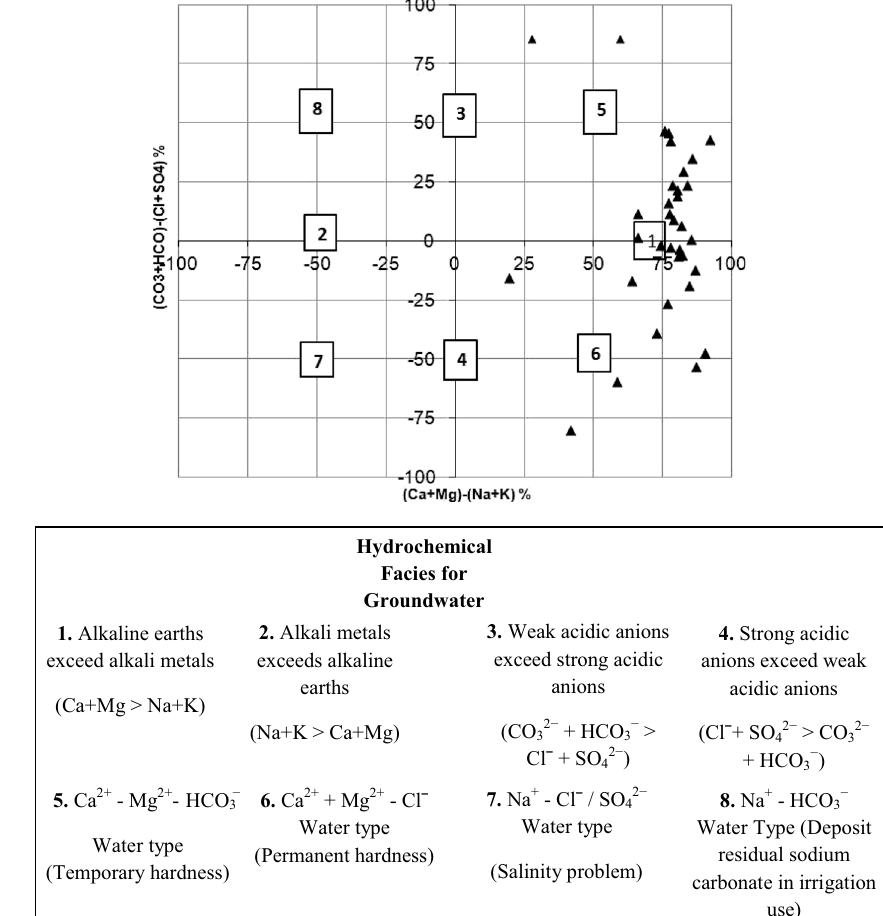
Fig. 33 Chadha’s diagram